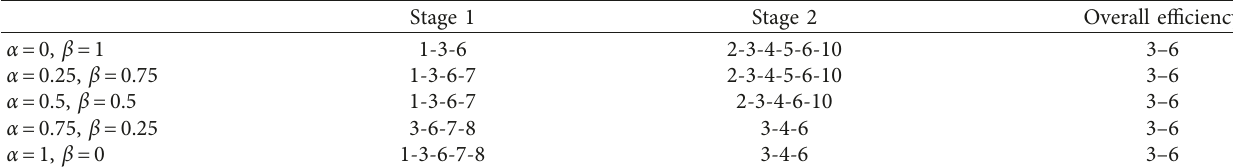
Table 7: Classification of efficient units at different a - β cut levels.